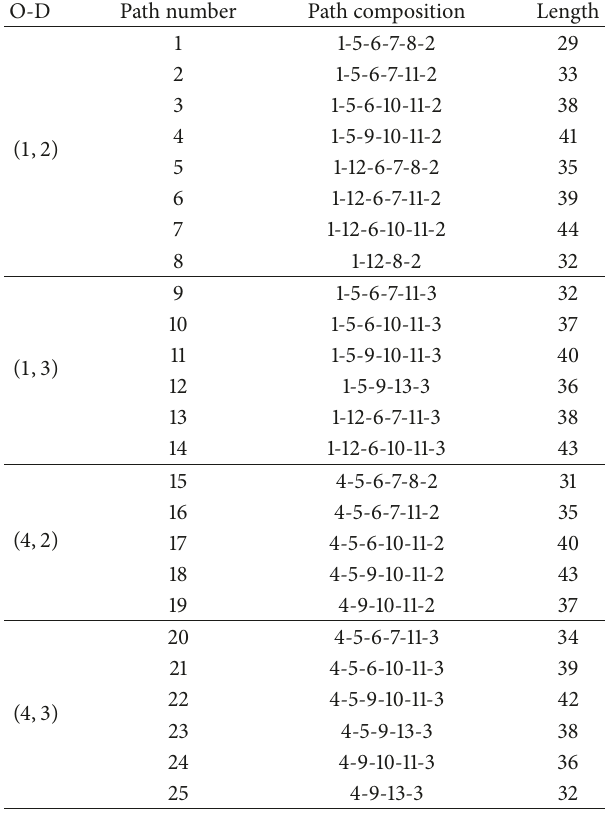
Table 2: Path compositions and lengths in the Nguyen-Dupuis network